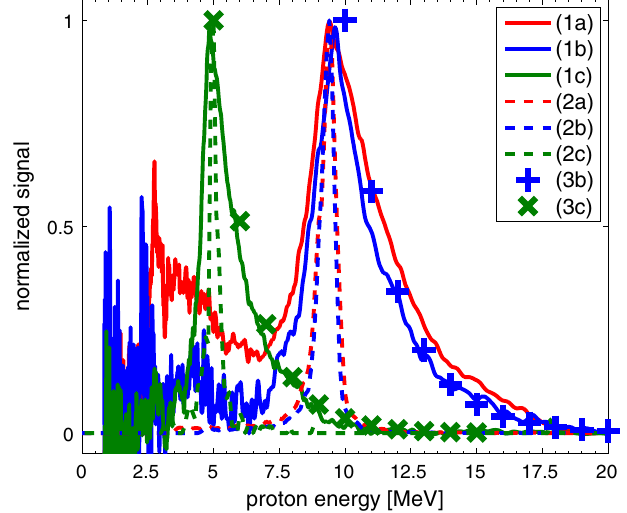
FIG. 8. Normalized time-of-flight results of the diamond de- tector (at 2.2 m from source) for three different shots: (1a) focusing of 9.4 MeV protons, (1b) focusing of 9.4 MeV protons with a 5 mm pinhole at 2.12 m, and (1c) focusing of 5 MeV, also using the pinhole. The dashed graphs (2a)–(2c) are the corresponding expected spectra from simulations. (3b) and (3c) show the exponential decaying spectrum for the high energies obtained from the RCF